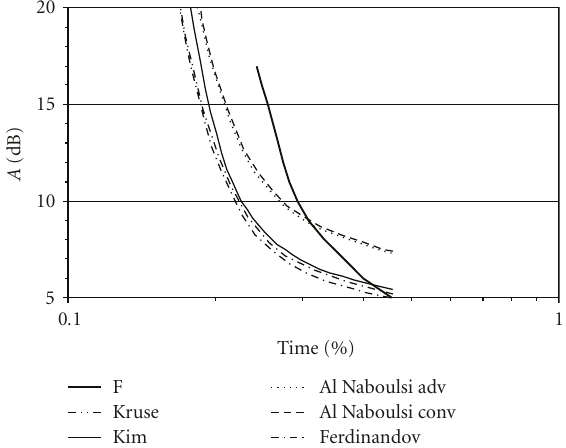
Figure 13: Comparison of the calculated CDs of attenuation due to fog only from visibility data with the measured distribution.